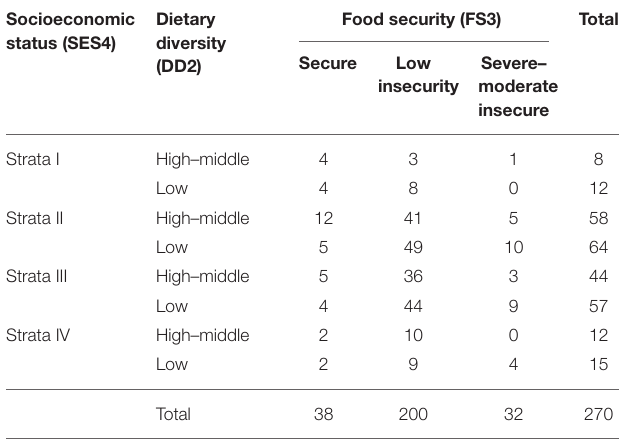
TABLE 3 | Cross classification of FS3, DD2, and